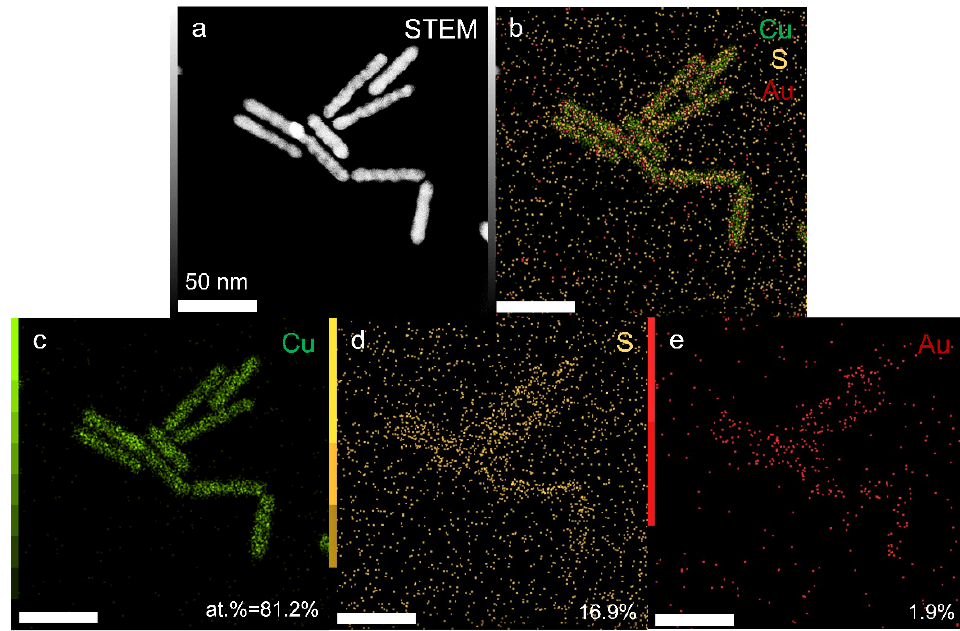
Figure 5. STEM-EDS elemental analysis of the sulfurized Cu NRs: ( a ) STEM image, ( b ) merged element mapping, ( c – e ) element distributions of Cu, S, and Au. The atomic percentage is also shown. The X-ray diffraction (XRD) patterns of initial and sulfurized Cu NRs are shown in Figure 6. The diffractive peaks of initial Cu NRs at 43.3°, 50.5°, and 74.1° are consistent with the diffractions from the (111), (200) and (220) planes of face-centered cubic (fcc) Cu. These three peaks of sulfurized Cu NRs shifted by about 0.2° to the left, to 43.1°, 50.2°, 73.9°, respectively. For the sulfurized Cu NRs, a raised wide band below 35° indicates that an amorphous structure may be formed after sulfidation. Three special peaks at 26.6°, 27.9° and 29.4° are matched with the (101), (0015), and (107) diffractions of the hexagonal close-packed (hcp) Cu 9 S 5 (Cu 1 . 8 S) phase. In addition, as can be seen in Figure S2, the three special peaks could correspond to the diffraction peaks at 26.5° (211), 26.6° (103), 27.9° (022) and 29.0° (113) of the orthorhombic Cu 7 S 4 (Cu 1 . 75 S) phase, or at 26.5° (002) and 29.2° (101) of the hcp Cu 2 S phase. Therefore, the coating layer may be a variety of mixed phases of copper sulfide, and it is termed as Cu 2−x S in this work. The formed Cu 2-x S layer by partial sulfidation could protect the inside of the Cu from oxidation. Meanwhile, Cu 2−x S is a p- doped semiconductor associated with copper deficiency, supporting tunable SPRs in the NIR spectral region [34,35], and has an active surface for catalytic applications [36].